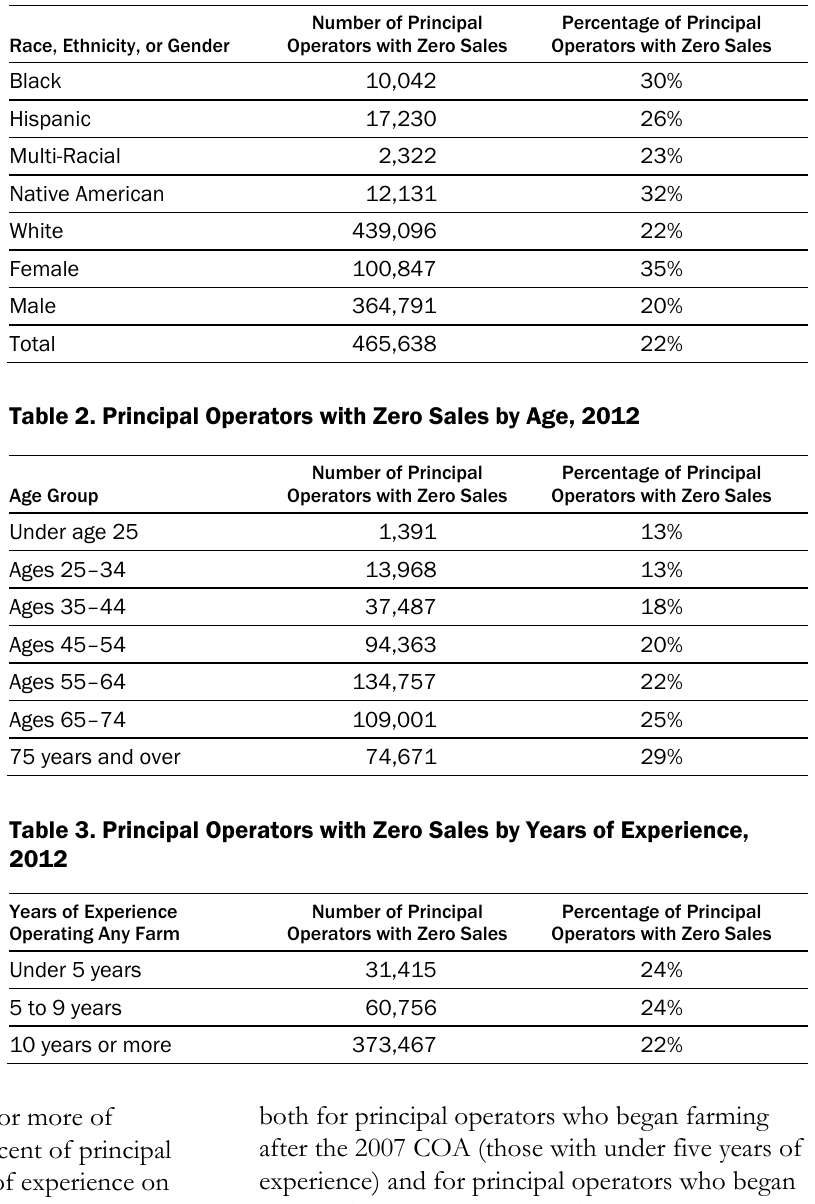
Table. 1. Principal Operators with Zero Sales by Race, Ethnicity, and Gender,